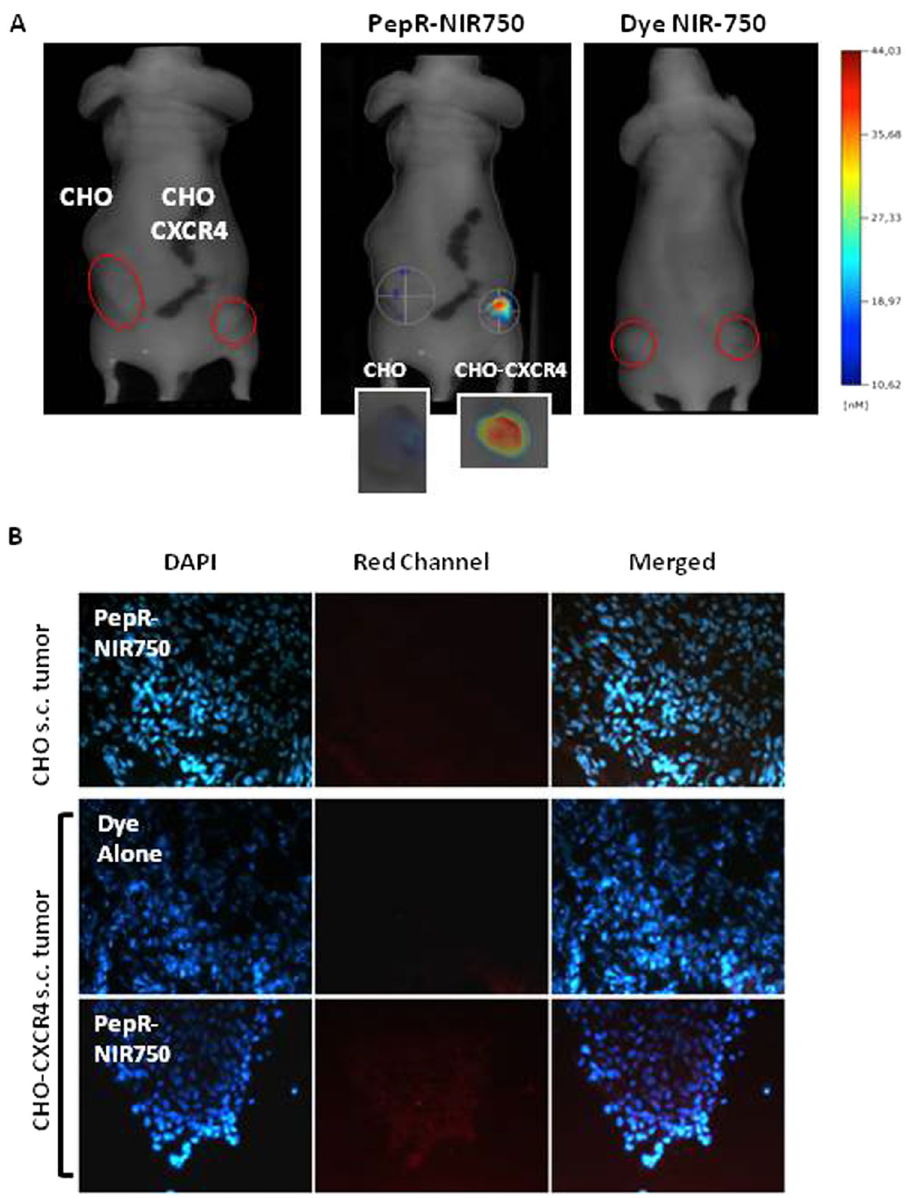
Figure 4. In vivo imaging of CXCR4 expressing tumors by PepR-NIR750. Imaging studies were carried out 1 hour after injection of NIR probe in CHO and CHO-CXCR4-derived s . c . tumor models. ( A ) 5 nM PepR- NIR750 or VivoTag-S 750 alone was i . v . injected and total body NIR fluorescence was monitored using fluorescence molecular tomography FMT4000. PepR-NIR750 detects CHO-CXCR4 tumor but not CHO tumor. No NIR fluorescence signal was detected in s . c . tumors from mouse injected with VivoTag-S 750 alone. ( A , smaller panels) After imaging study mice were euthanized and tumors explanted were observed by FMT4000. ( B ) 5 µ m sliced obtained from snap frozen tumors were stained with DAPI and analyzed for NIR fluorescence signals (red) by fluorescence microscope Axioscope